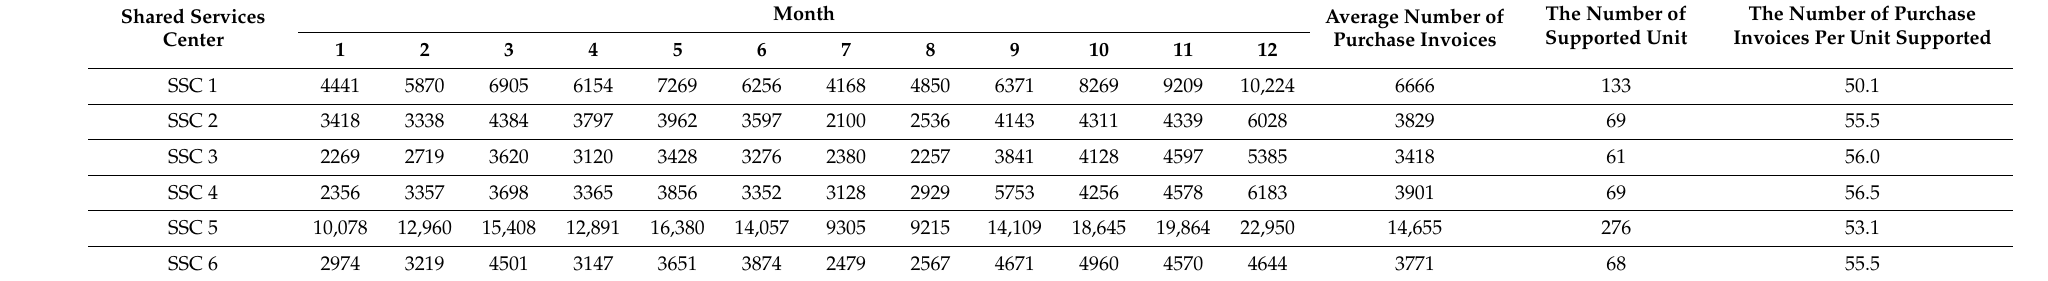
Table 2. Calculation of the average number of invoices per 1 supported unit (based on the number of invoices generated by units in a given year). Shared Services